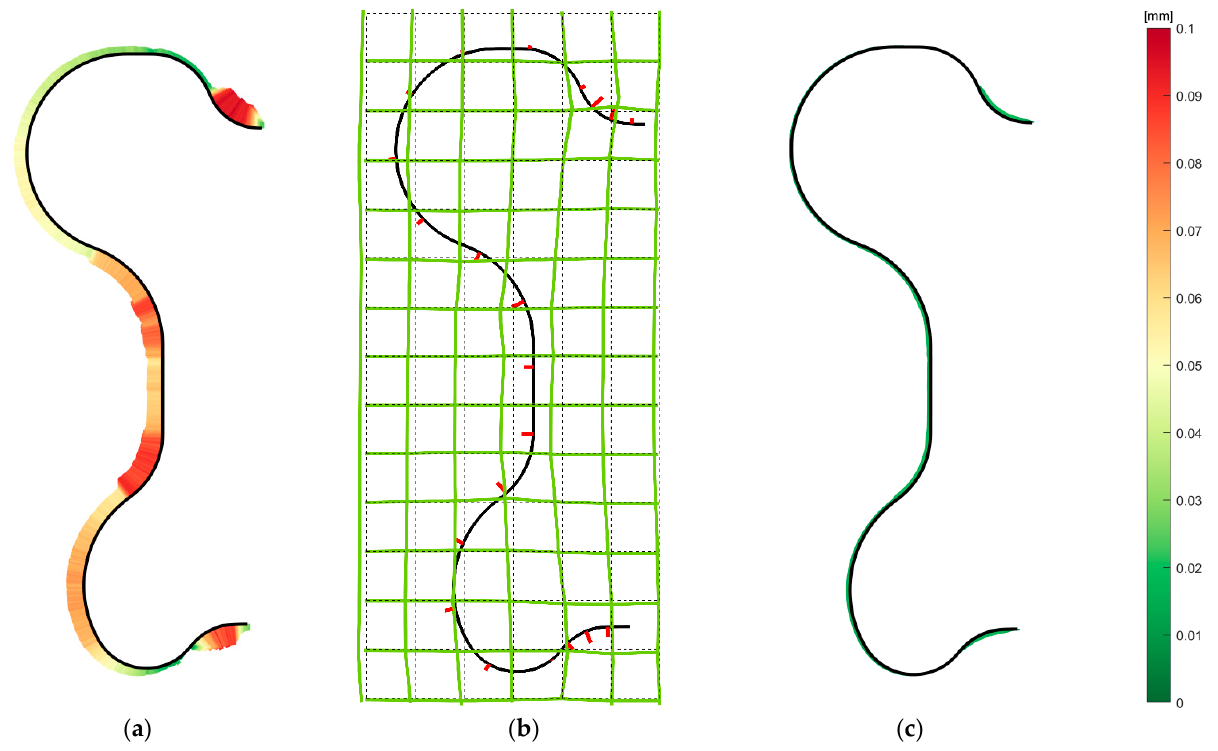
Figure 13. Increase in workpiece accuracy: ( a ) evaluation of training workpiece; ( b ) generation of correction mesh based on selected measured points; ( c ) evaluation of testing workpiece accuracy with an activated ad hoc correction table.